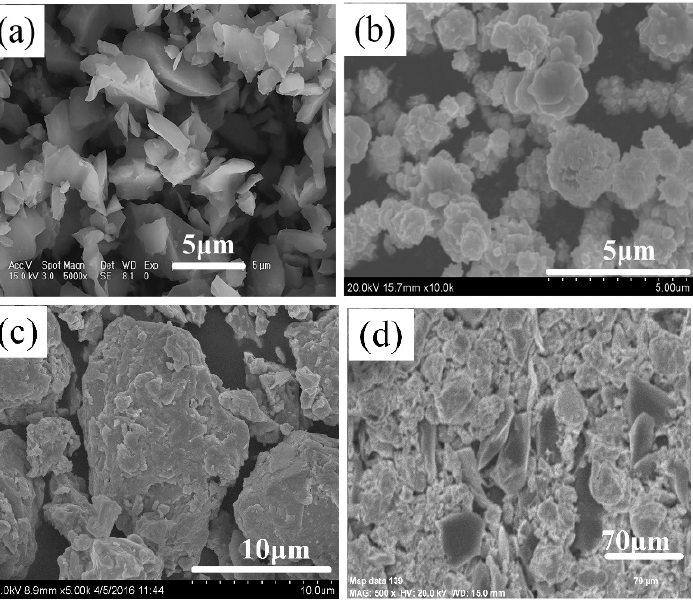
Figure 11. Microstructure of ( a ) Ni, ( b ) Zr, ( c ) B 4 C raw material powder, and ( d ) the unreacted region of the quenched bar.